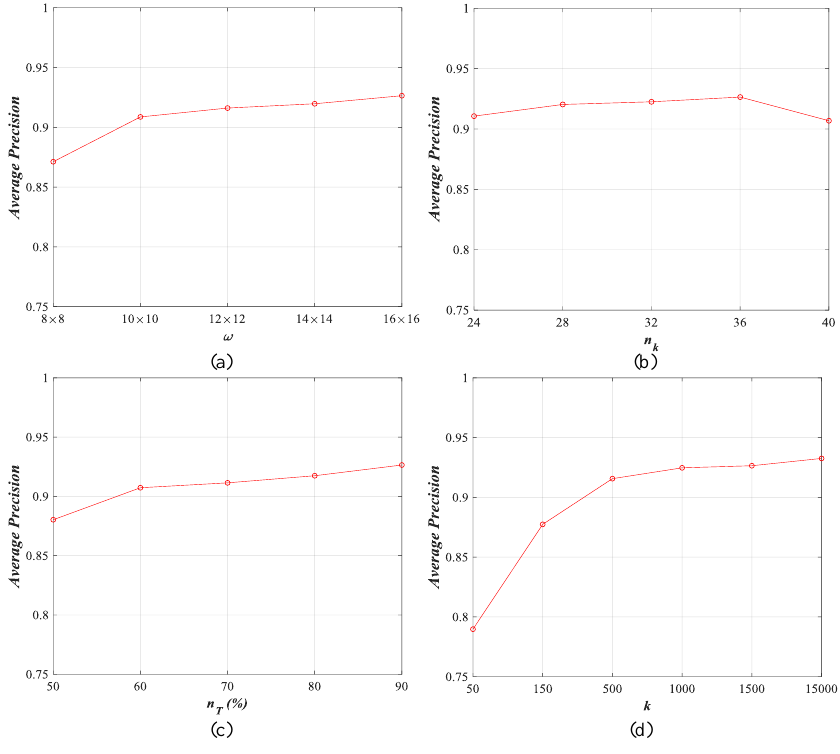
Figure 25. Influence of different parameters for ImgDB3. ( a ) ω ; ( b ) n k ; ( c ) n T ; ( d ) k